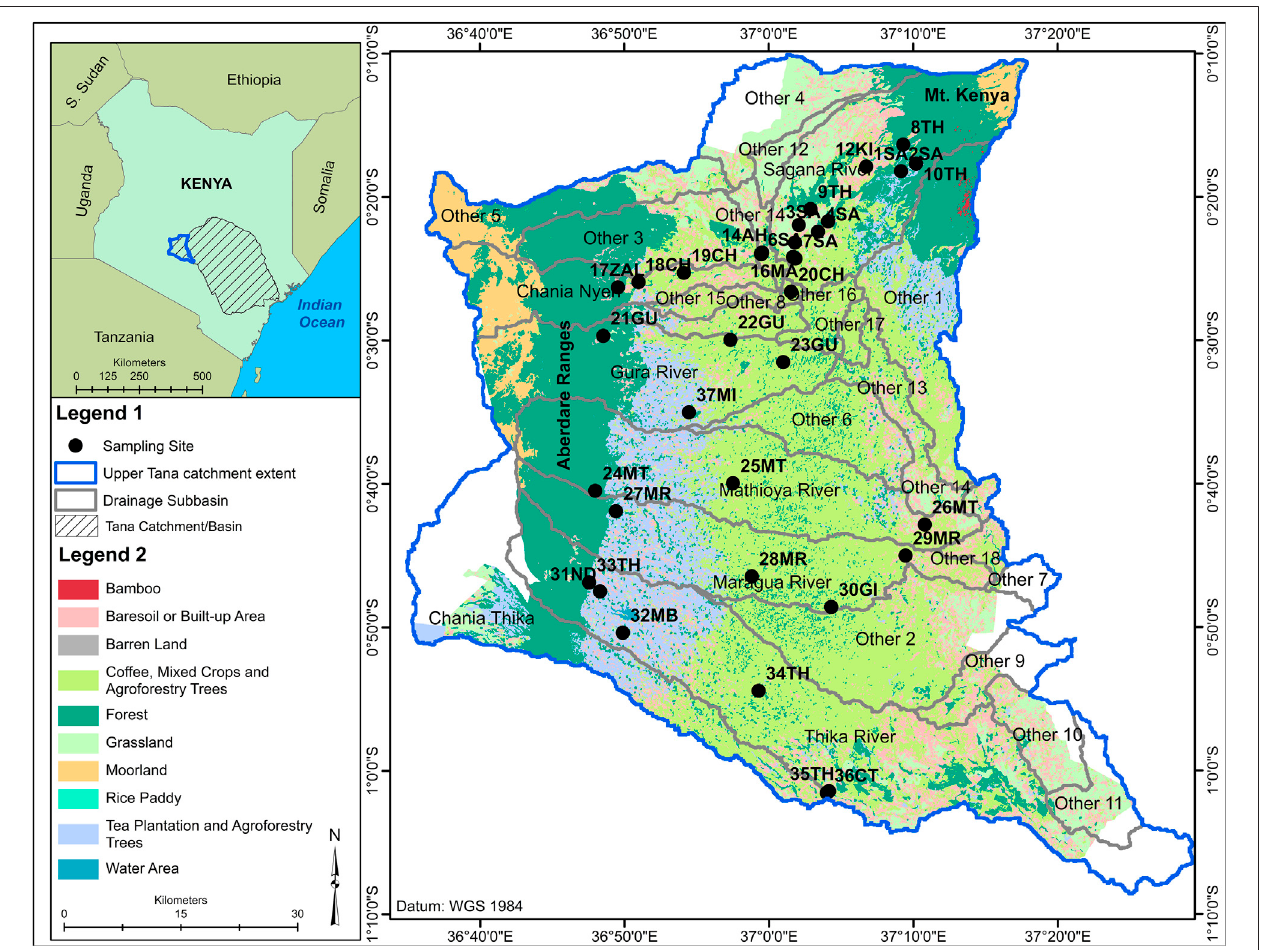
FIGURE 1 | A map of the Upper Tana River watershed showing sampling sites and the six major sub-catchments of rivers Sagana, Chania (in Nyeri), Gura, Mathioya, Maragua, and Thika. Land use and cover represent levels of disturbances with forests, and tea is the least disturbed area, coffee and mixed agriculture are moderately disturbed areas, while intensive horticulture and livestock farming indicate severely disturbed areas. For full names of sampling sites ’ abbreviations, see Table 1 .